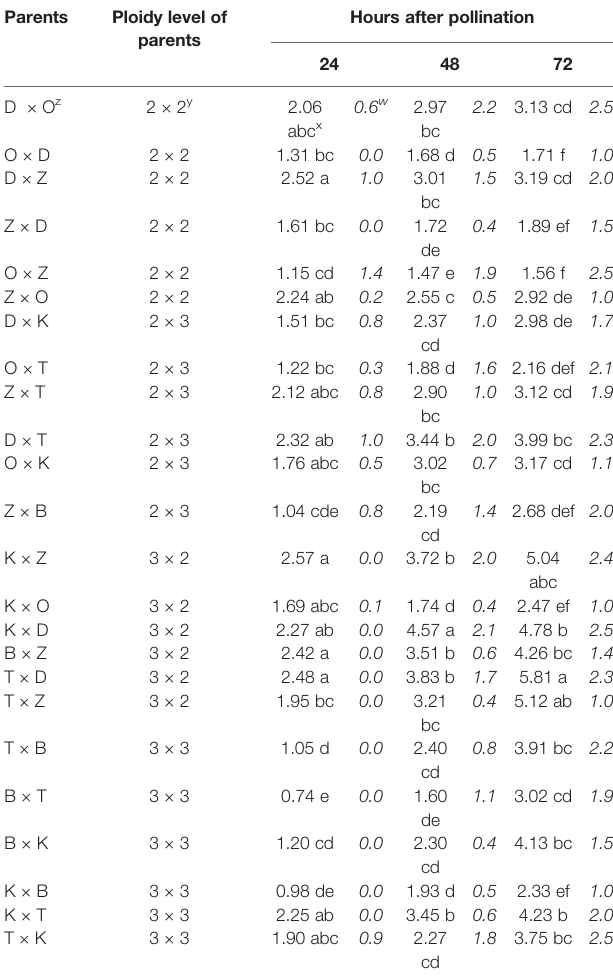
TABLE 2 | Average pollen tube length (mm) and density (in italics) of pollen tubes from fl owers of interploidy and intraploidy crosses of Hydrangea macrophylla collected 24, 48, and 72 h